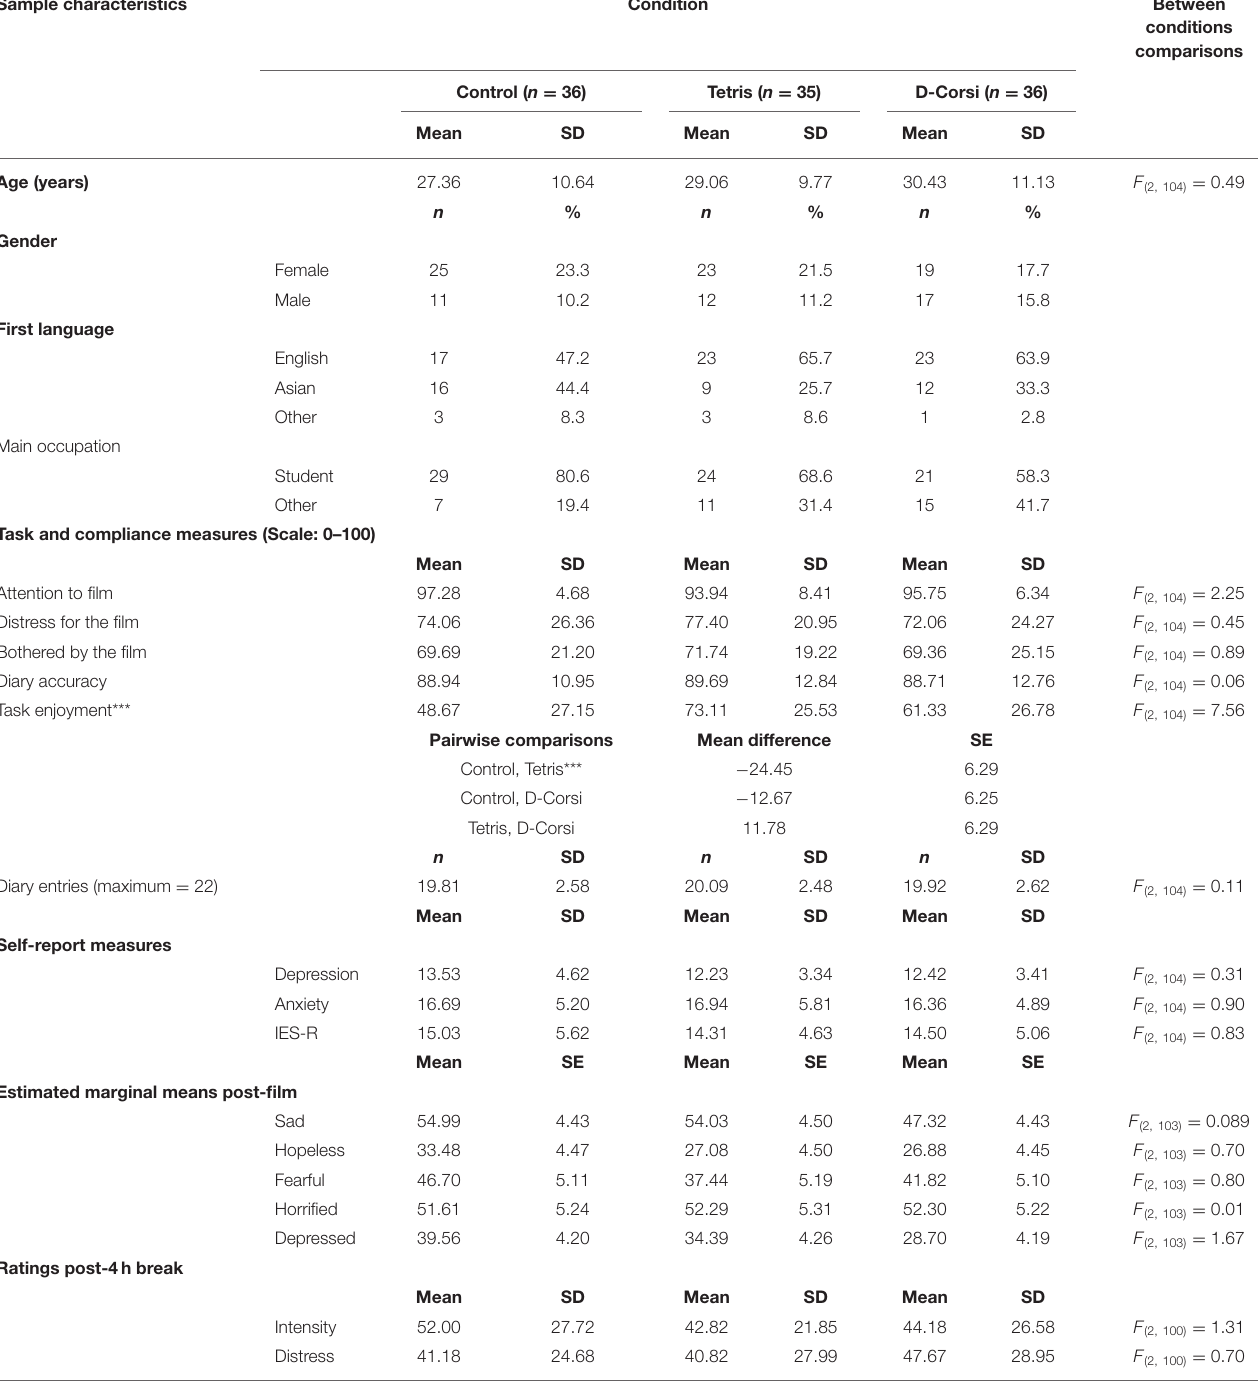
TABLE 1 | Sample, task and compliance measures, self-report measures. Sample